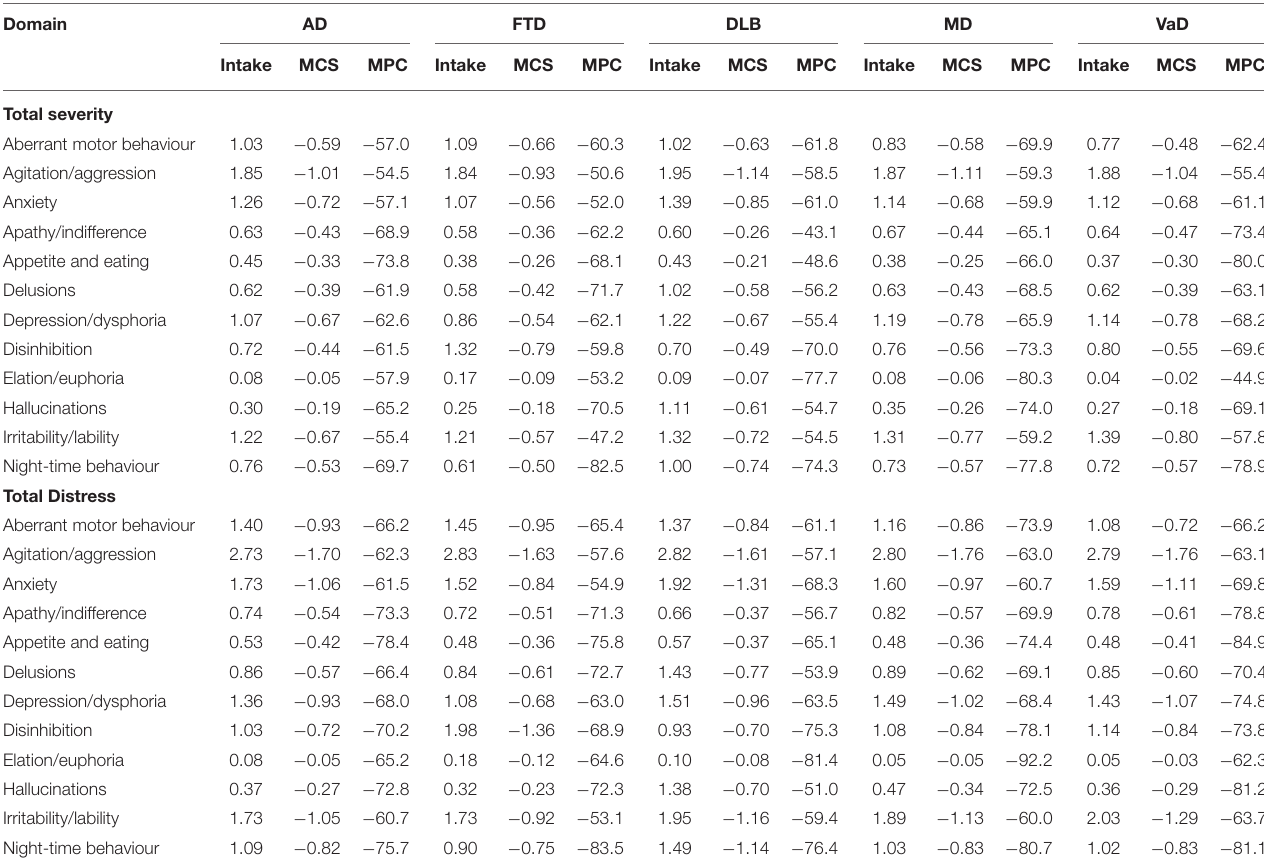
TABLE 7 | Clinical impact of DSA programs on NPI total severity scores and distress scores by NPI symptom domain score and dementia subtype. Domain AD FTD DLB